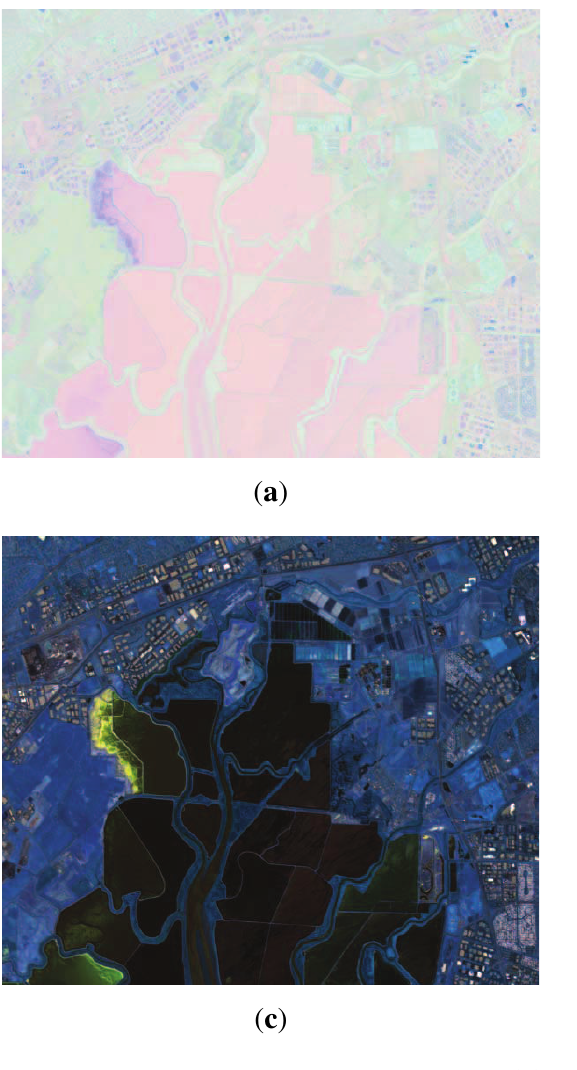
_ igm with range of (511 : 1022 , 1 : 614) 02